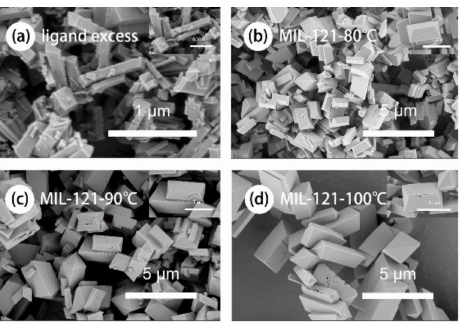
Figure 2. SEM images of ( a ) MIL-121-ligand excess, ( b ) MIL-121-80 ◦ C, ( c ) MIL-121-90 ◦ C, ( d ) MIL- 121-100 ◦ C.